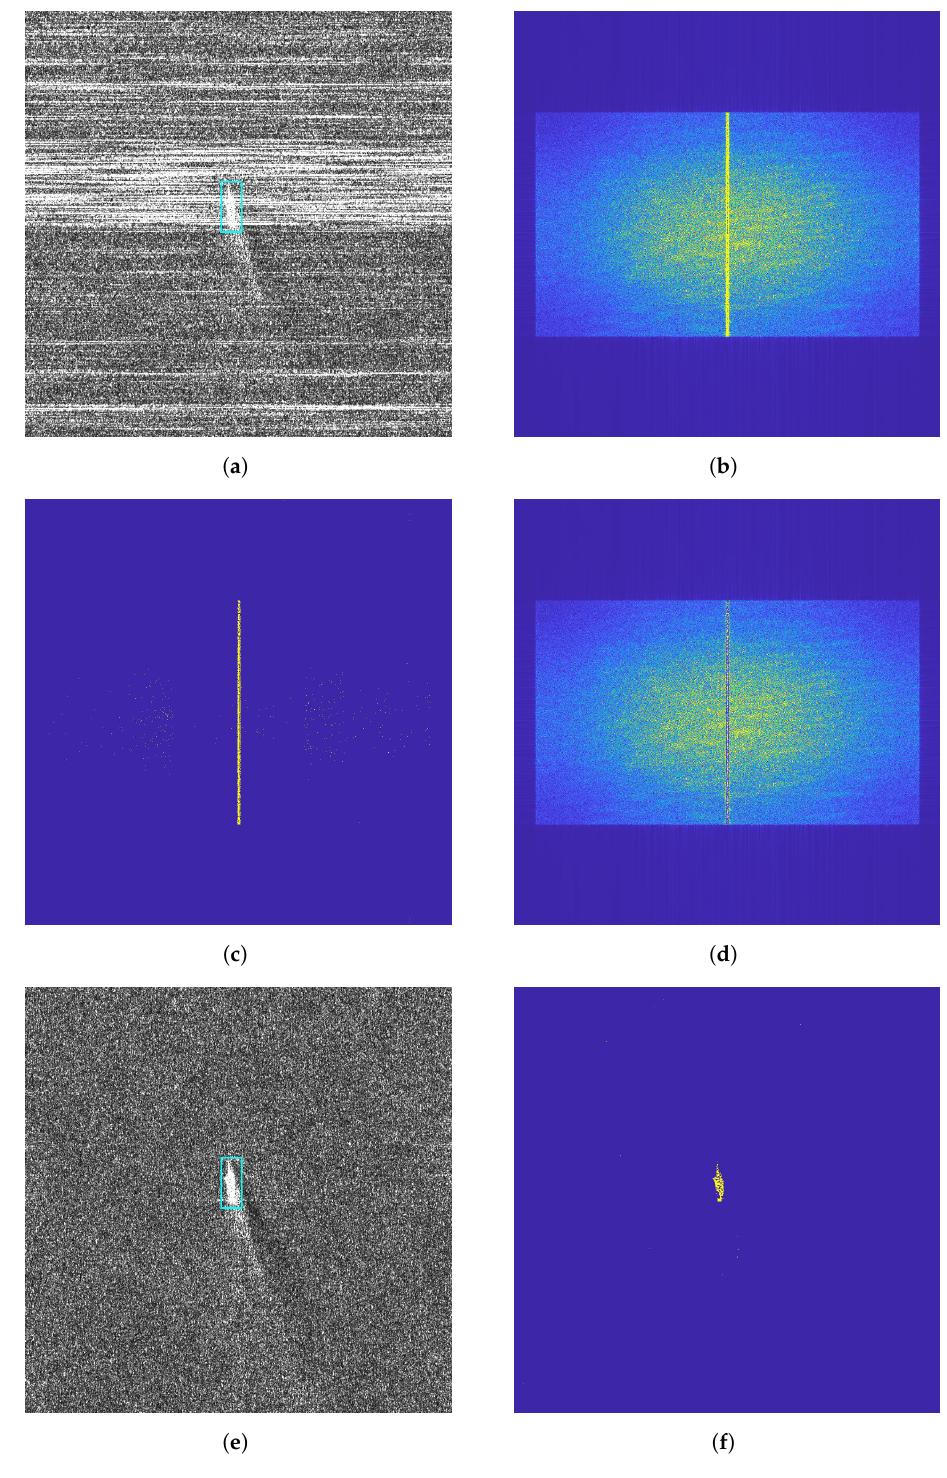
Figure 2. Images in the processed steps of the first experiment. ( a ) SAR image plus simulated RFI; ( b ) Image 2-D spectrum; ( c ) CFAR detection of RFI from the 2-D spectrum; ( d ) Weighted 2-D spectrum; ( e ) Output clean image; ( f ) CFAR detection of ship from the clean